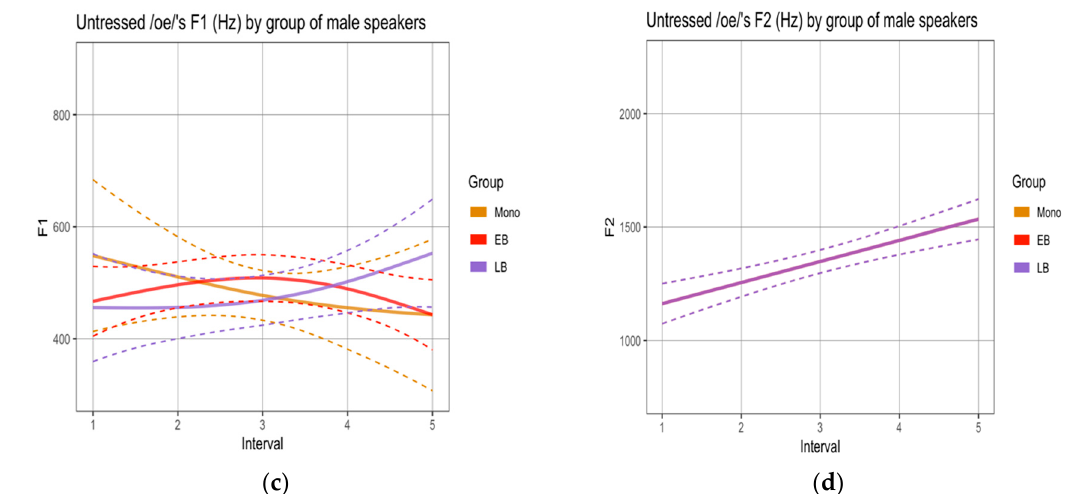
Figure A3. SSANOVAs for male formant trajectories across five intervals within the sequences ( a ) / ae / (F1); ( b ) / ea / (F1); ( c ) / oe / (F1); and ( d ) / oe / (F2) produced by each group of speakers (M, EB, LB) in the narrative task.